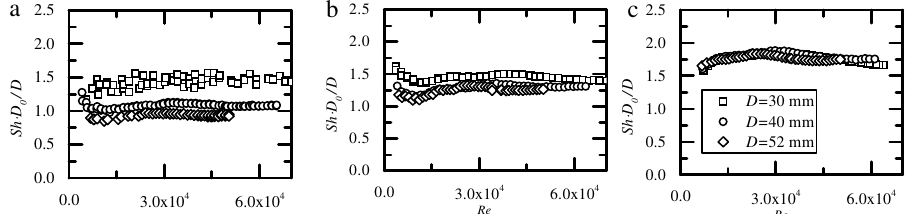
Fig. 2. Modified Strouhal number dependence of Reynolds number for three swirl cases and diameters of nozzle: S g =0.53 (a), S g =0.94 (b), and S g =1.37 (c).